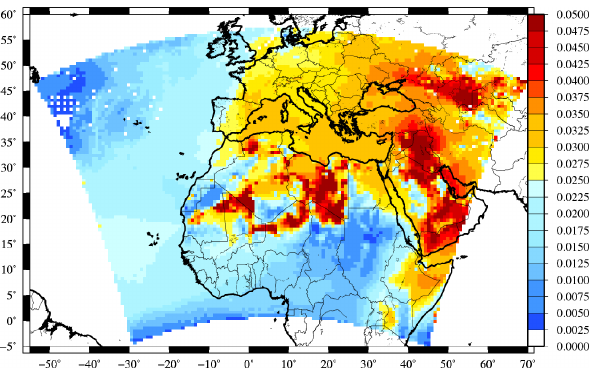
Figure 9. Modelled ratio of nssCA 2 + on total mineral dust concen- trations. The ratio corresponds to the yearly averaged value.